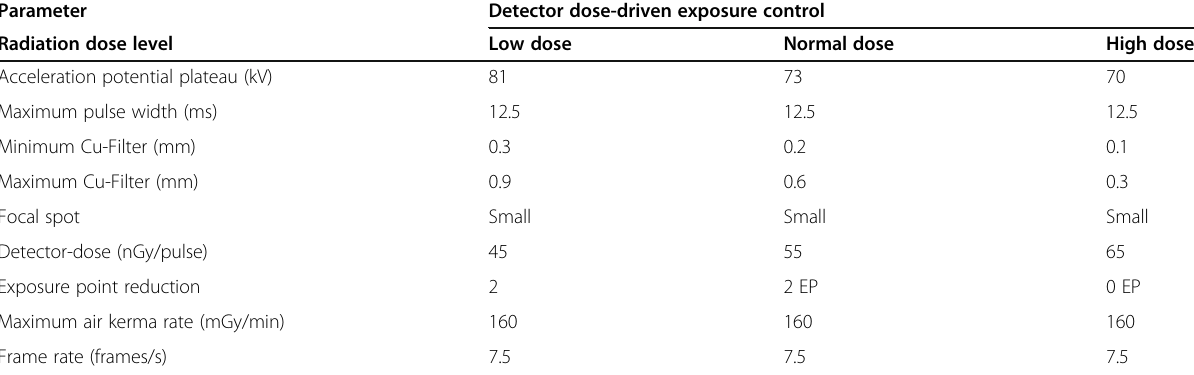
Table 1 Fluoroscopic image acquisition protocols of the detector dose-driven exposure control